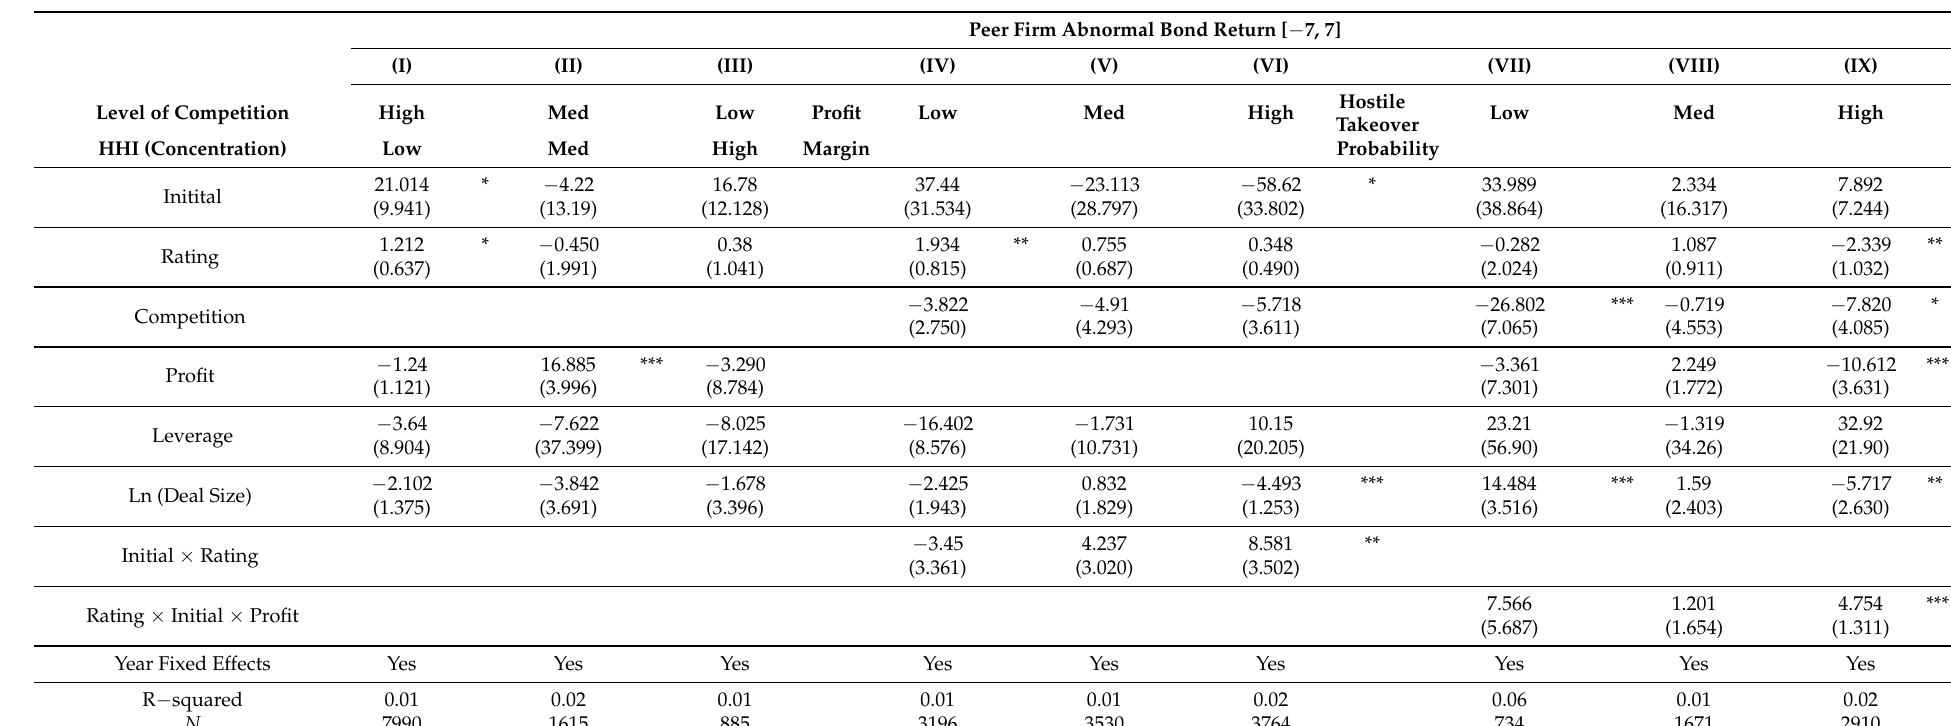
Table 6. Between Firms Multivariate Regression